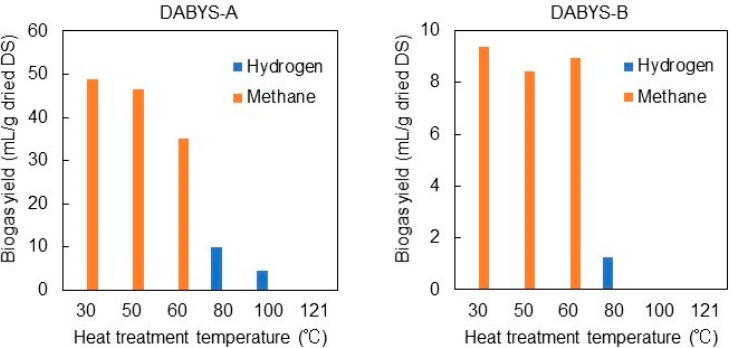
Figure 1. Biogas yields of the heat-treated DABYS microflorae. Data are means for two-time gas chromatography analysis.